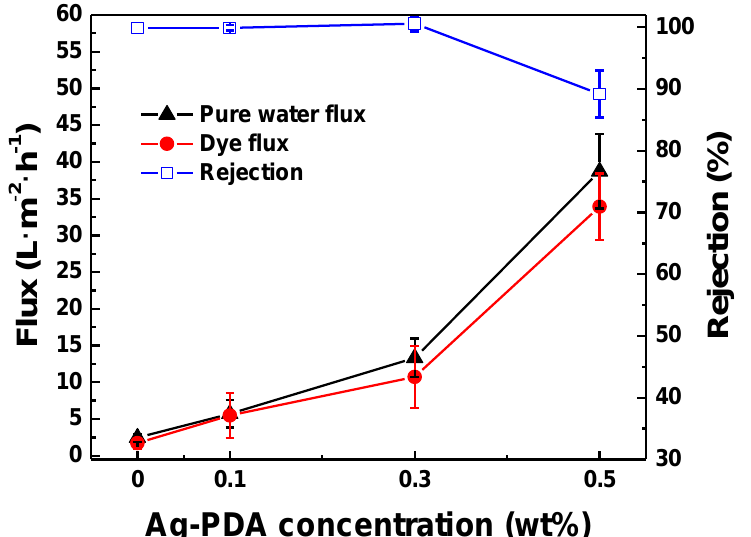
Figure 8. Effect of Ag-PDA concentration on membrane performance. Feed = 50 ppm. Rose Bengal; Operating pressure 4 bar; Operating temperature = 30 °C.